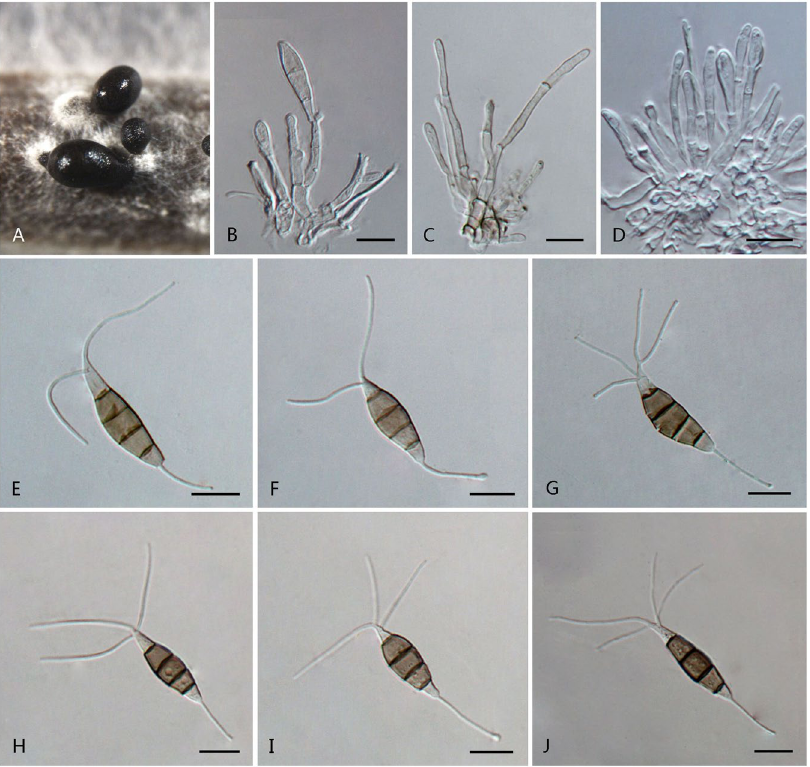
Figure 9. Pestalotiopsis jiangxiensis (from ex-holotype culture CGMCC 3.18218 ( = LC4399)). ( A ) Conidiomata sporulating on pine needle. ( B–D ) Conidiophores. ( E–J ) Conidia. Scale bars = 10 μ